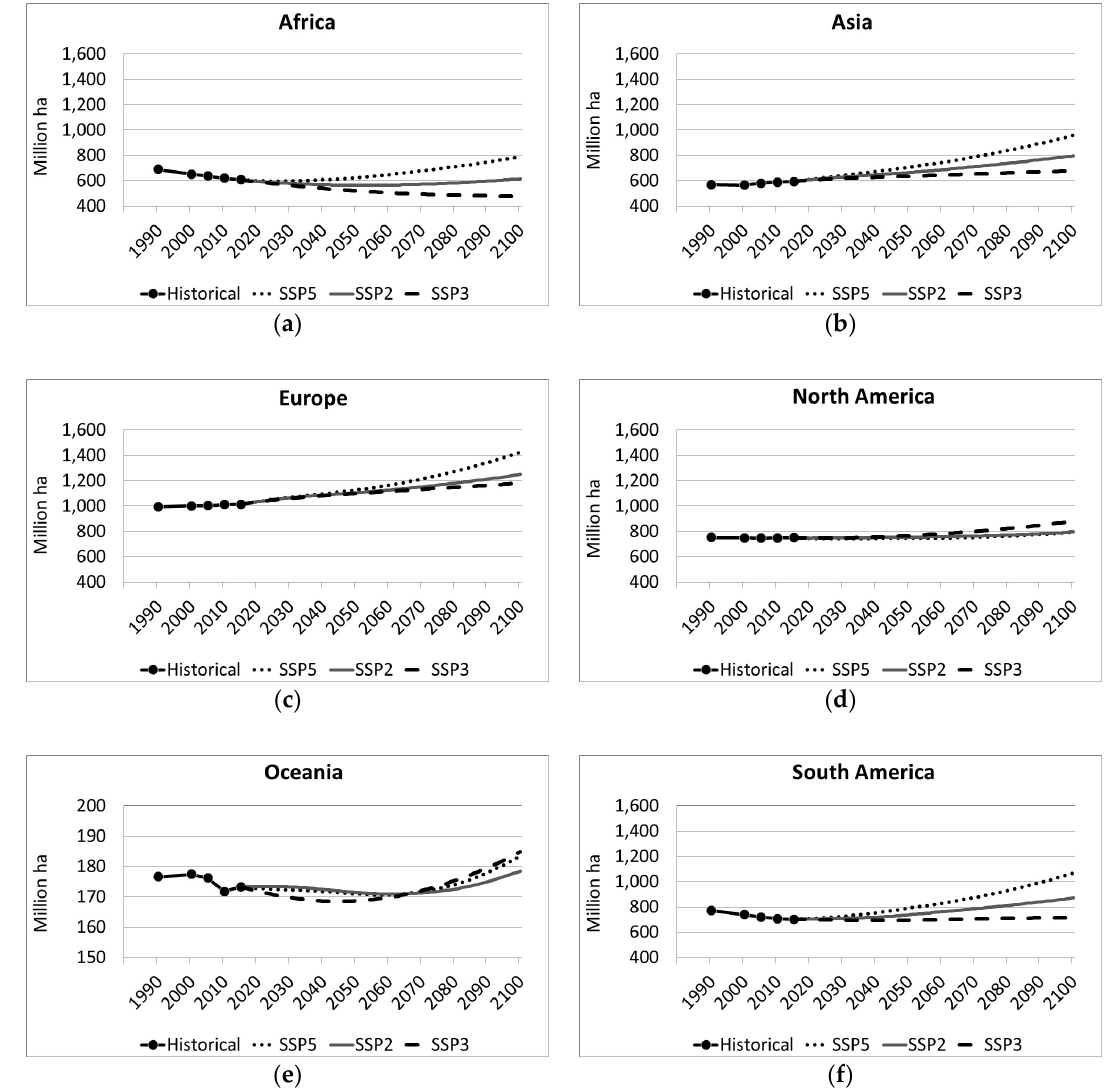
Figure 2. Projected total forest area (million ha) for major world regions under different shared socioeconomic pathways (SSPs), 2015–2100. Projected explanatory variables driving total forest area projection include per capita income, its squared term, labor per unit forest area, and rural population density. The results represent 48 countries in Africa ( a ), 46 in Asia ( b ), 36 in Europe ( c ), 17 in North America ( d ), nine in Oceania ( e ), and 12 in South America ( f ).